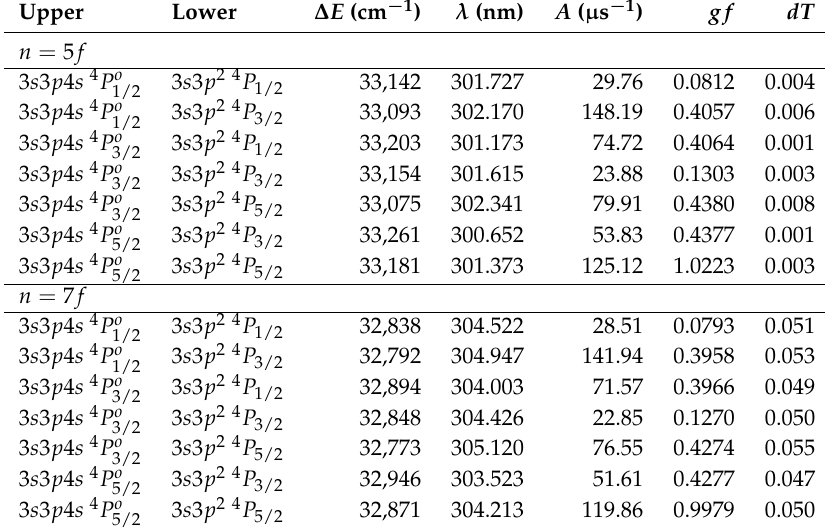
Table 4. Ab initio electric dipole (E1) transition data for the 3 s 3 p 2 4 P to 3 s 3 p 4 s 4 P o transition computed in the length form from valence and core-valence results.